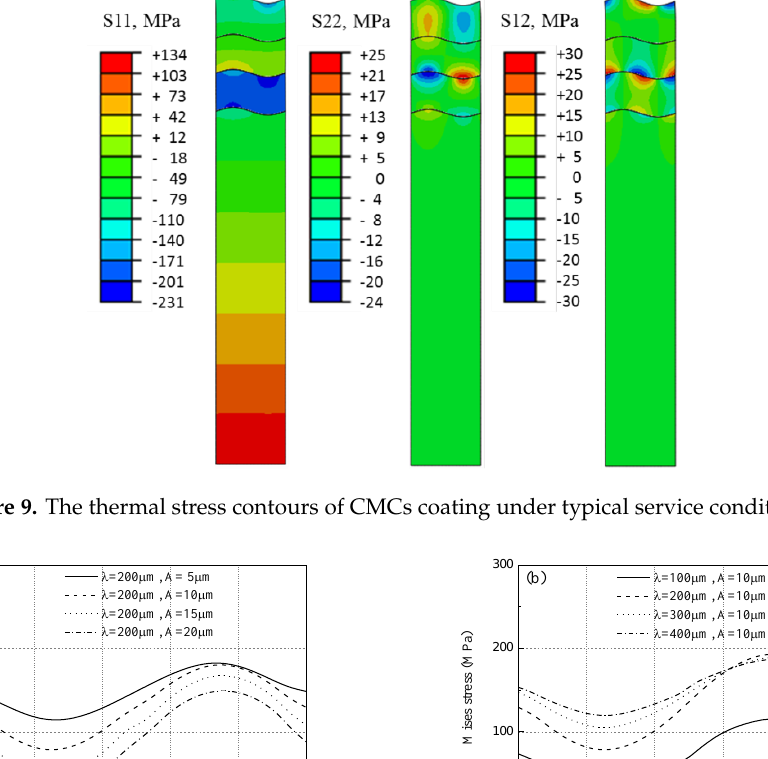
and compressive stress are almost the same as those of the thermal residual stress. The biggest